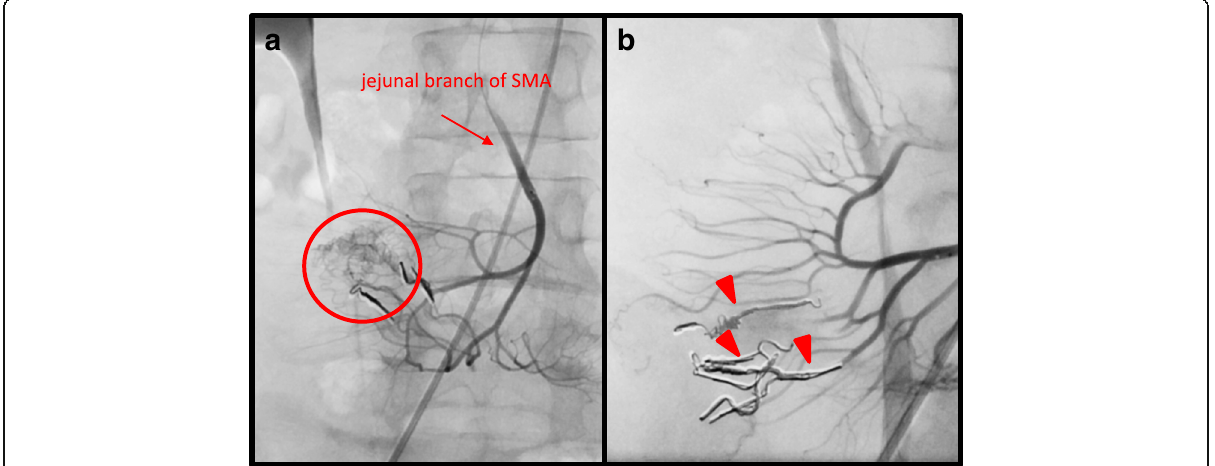
Fig. 2 Second selective angiography of SMA (red arrow). a Extravasation (red circle) detected at the same AVM embolized during the first angiography. Red arrow indicates the jejunal branch of the SMA. b Additional metallic coils (red arrowheads) embolized to 3 vasa recta branches close to the previously embolized arteries, with no extravasation evident after embolization